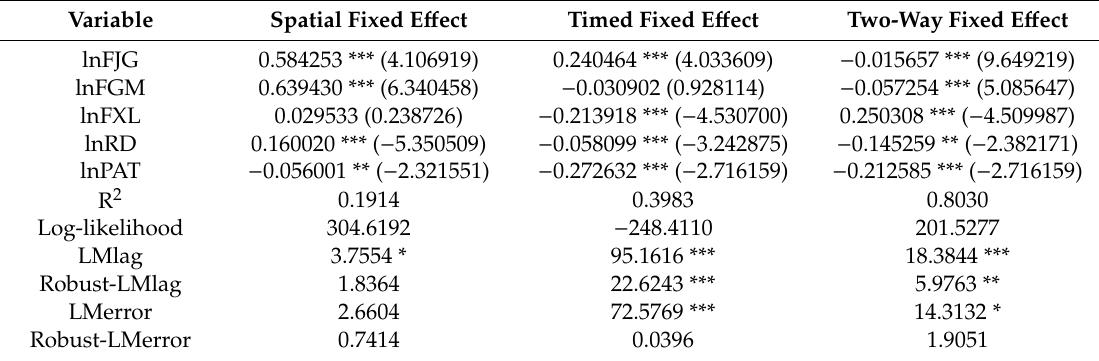
Table 2. Estimation results of traditional hybrid panel data